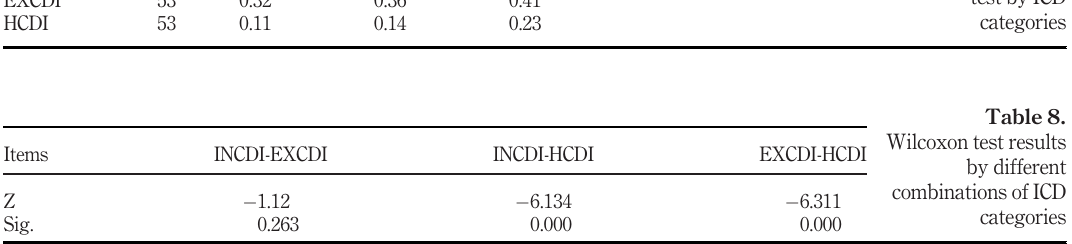
Table 7. Results of Friedman